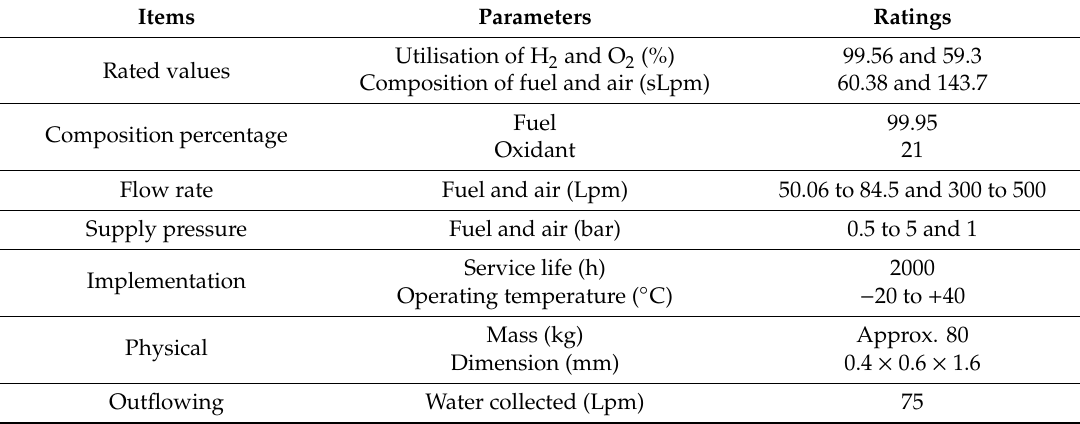
Table 2. Physical parameters of the fuel cell